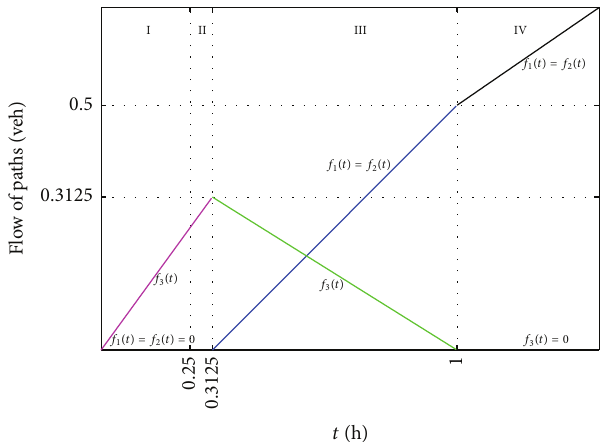
Figure3:Equilibriumflowofthedynamicnetwork( 𝑡( h ) versusflow